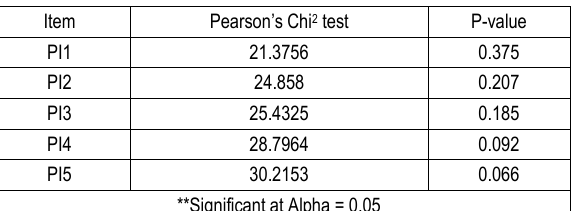
Table 12. Association between income and purchase